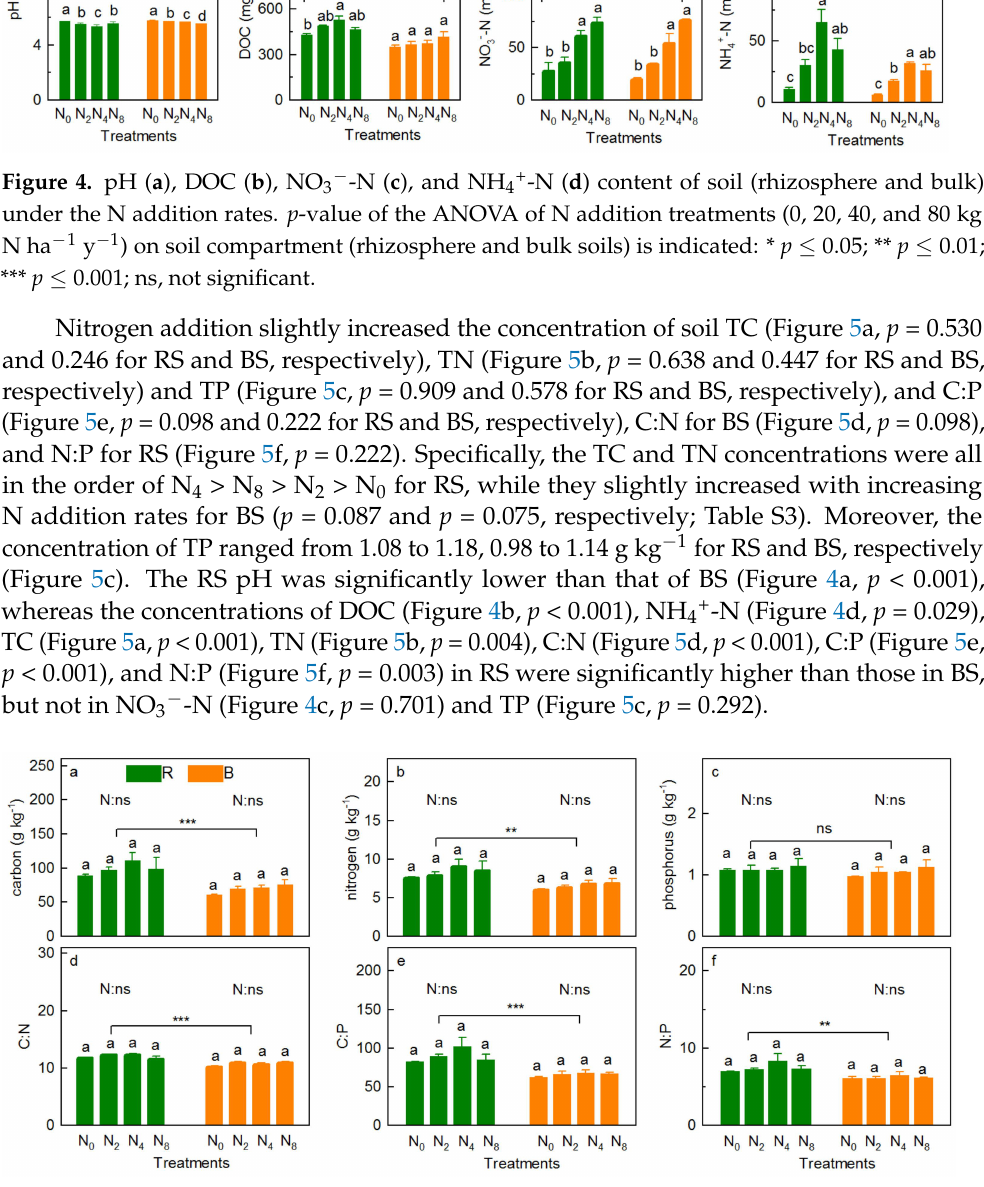
Figure 5. Concentrations of TC ( a ), TN ( b ), and TP ( c ), and C:N ( d ), C:P ( e ), and N:P ( f ) of soil (rhizosphere and bulk) under the N addition rates. p -value of the ANOVA of N addition treatments (0, 20, 40, and 80 kg N ha − 1 y − 1 ) on soil compartment (rhizosphere and bulk soil) is indicated: ** p ≤ 0.01; *** p ≤ 0.001; ns, not